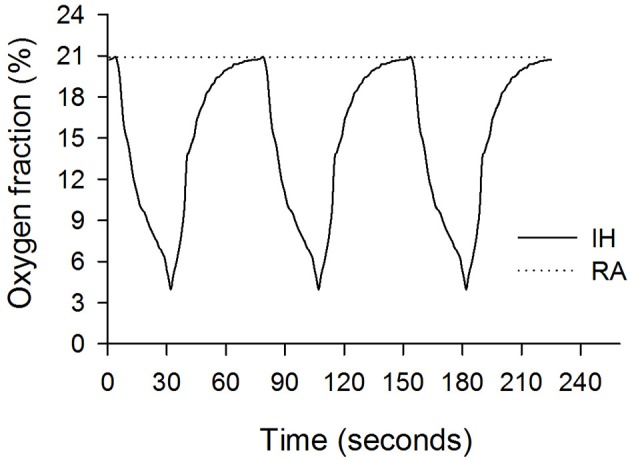
Oxygen fractions during intermittent hypoxia (IH, solid line) and room air (RA, dashed line) recorded in the Plexiglas chambers.